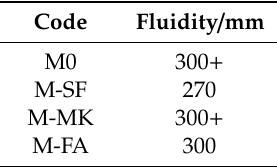
Table 3. Mixing ratio and fluidity of potassium magnesium phosphate cement